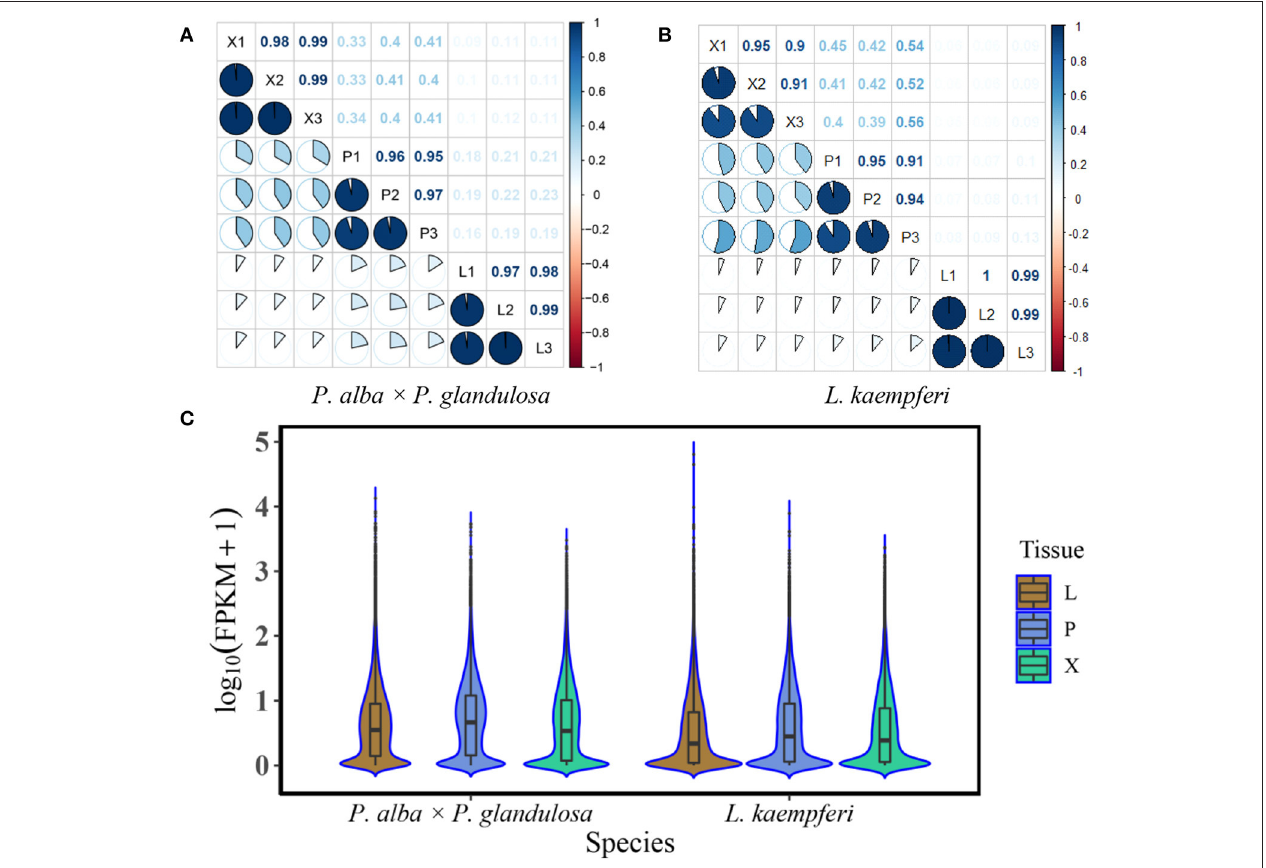
FIGURE 1 | Correlation analysis and the gene expression distributions of different tissues in the two tree species. (A) Correlations among different tissues and replicates of the angiosperm Populus alba × P. glandulosa clone 84K ( P. alba × P. glandulosa ). (B) Correlations among different tissues and replicates of the gymnosperm Larix kaempferi (Lamb.) Carr ( L. kaempferi ). (C) Gene expression distribution of different tissues (Xylem: X; Phloem: P; Leaf: L) in two tree species. Box plots appear in the center of the violin graphs. The top edge, middle edge, and bottom edge represent third quartile, median, and first quartile, respectively. The expression levels of the genes were standardized by the log 10 (FPKM) algorithm. FPKM represents Fragments per Kilobase